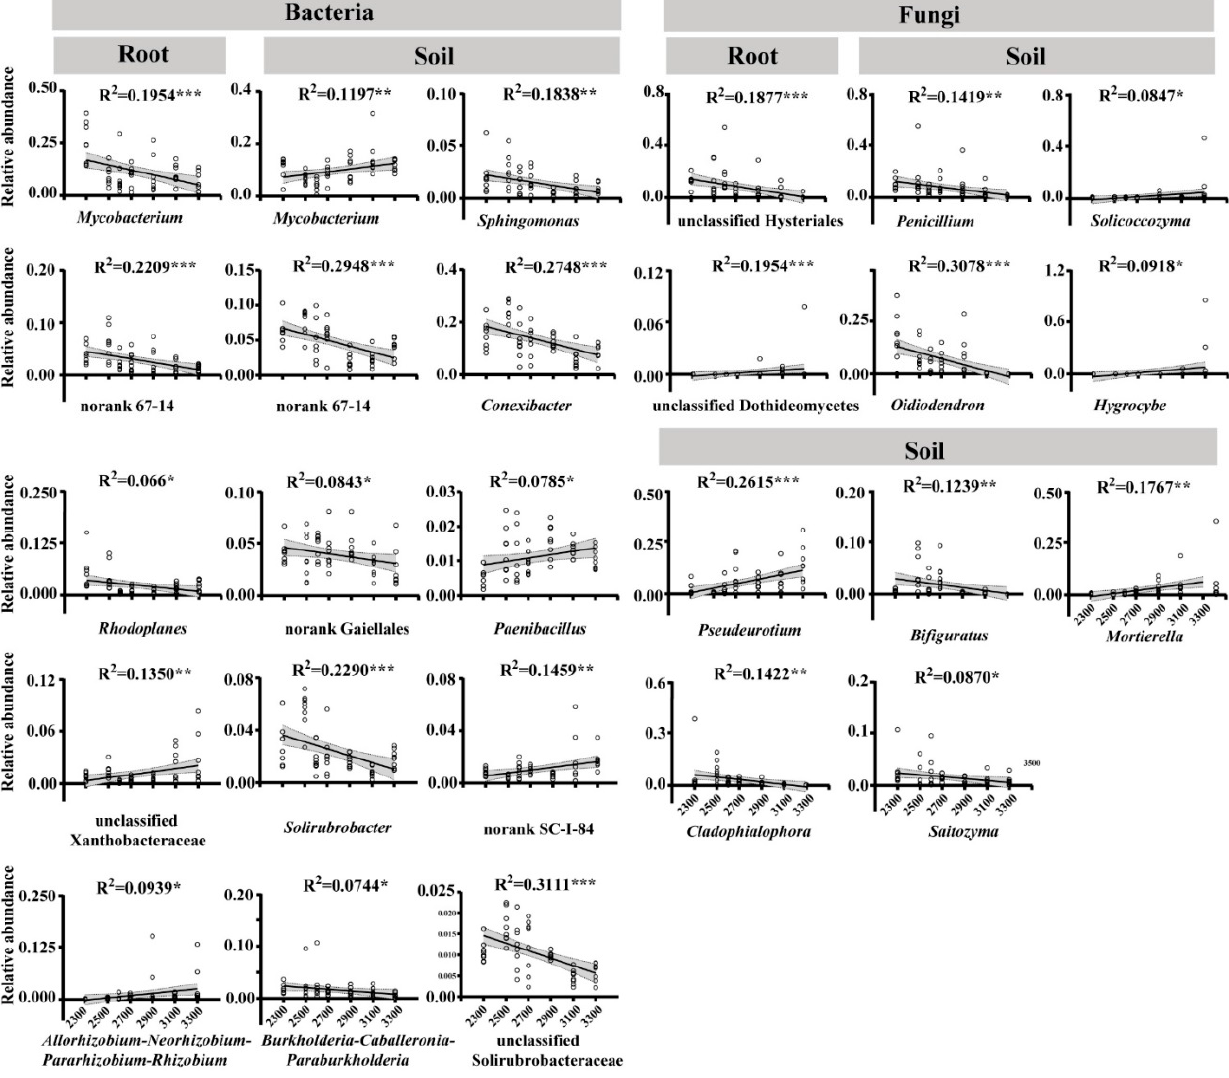
Figure 4. Variation in the relative abundance of genera with elevational gradient. The line indicates the linear regression fit, and the shaded band represents the 95% confidence level. R 2 was employed to determine the models that fit the whole elevational gradient. Significant difference: * p ≤ 0.05, ** p ≤ 0.01, *** p ≤ 0.001.